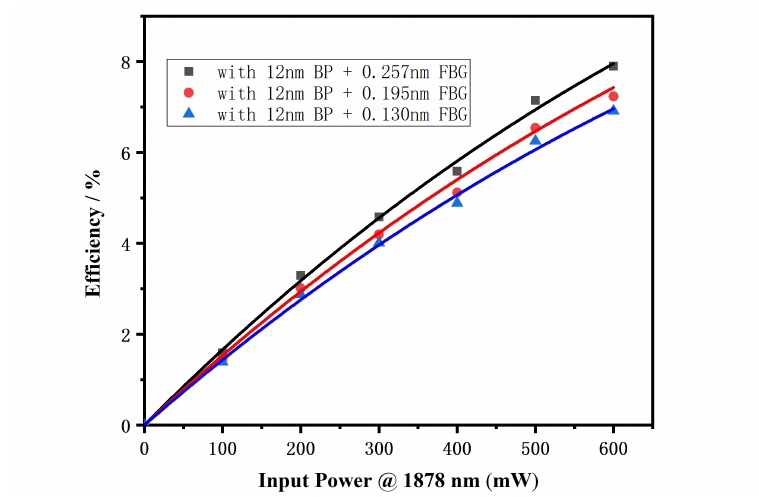
Figure 8. The efficieny with three filters of different bandwidths, respectively.The black squares are the result when the bandwidth is 0.257 nm, the red circles are the result when the bandwidth is 0.195 nm, and the blue triangles are the result when the bandwidth is 0.130 nm.